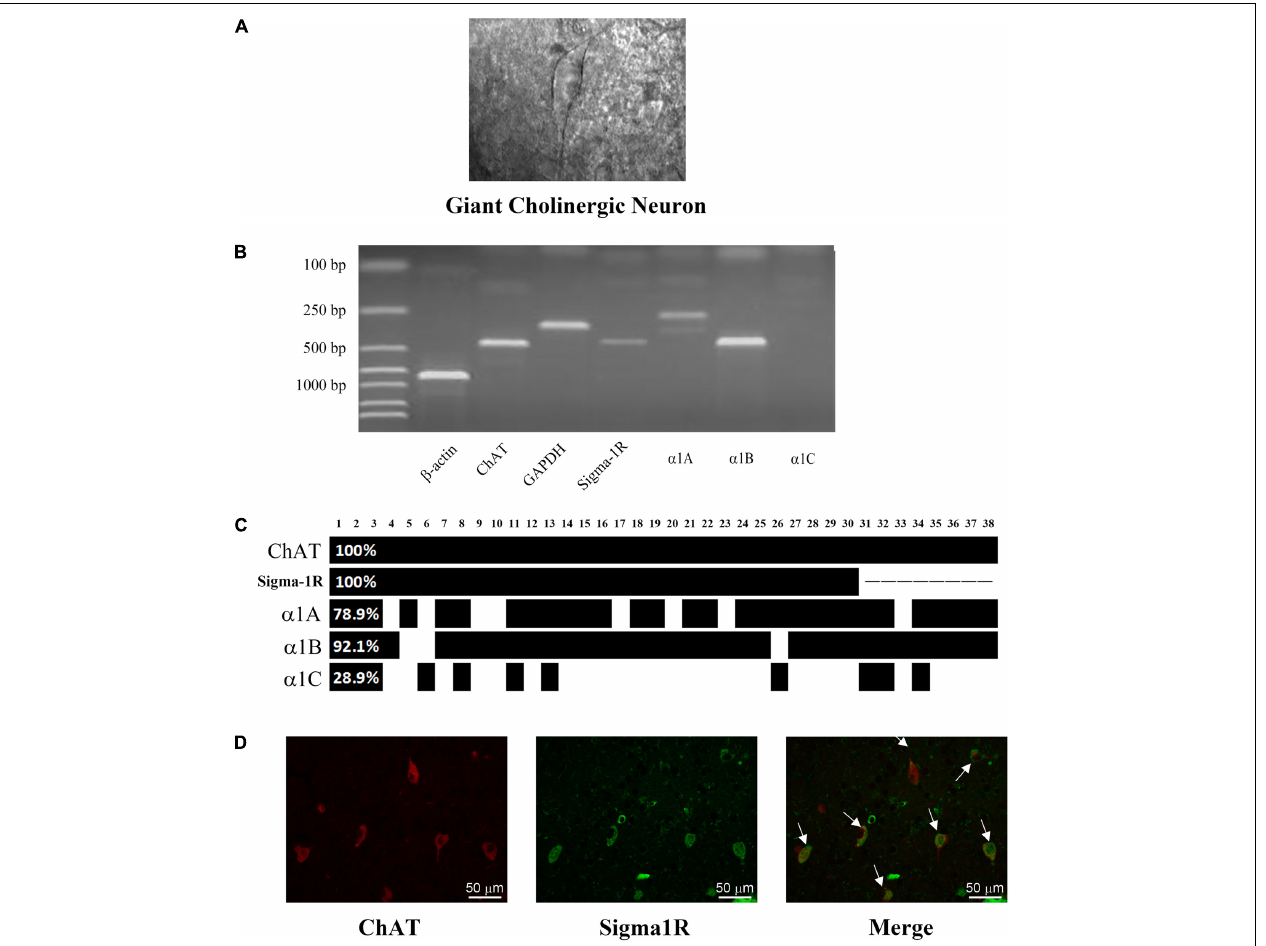
FIGURE 1 | Identification of the expression of N-type Ca 2 + channel and sigma-1 receptor in ChIs. (A) An IR-DIC image of a striatal slice illustrating the characteristic appearance of giant cholinergic interneurons (ChIs). (B) Representative photograph of single-cell reverse transcription polymerase chain reaction (scRT-PCR). Experiment products were stained in a 2% agarose gel. Molecular mass markers were shown in the first lane. β -actin and GAPDH were introduced as positive control. The presence of ChAT indicated the aspirated cell was a ChI. (C) Bar plot indicated the co-expression of ChAT, sigma-1 receptor and α 1A-C in ChIs by scRT-PCR. ChAT and sigma-1 receptor were in every detected neuron. The α 1B subunit of N-type Ca 2 + channel was found in 92.1% detected cells. (D) Immunofluorescence of successive paraffin-embedded rat striatum slice observed under 40 × objective lens. Left: using the anti-sigma-1 receptor antibody at a dilution of 1:20 and FITC-conjugated affinipure goat anti-rabbit IgG. Middle: Using the anti-ChAT antibody at a dilution of 1:200 and TRITC-conjugated affinipure rabbit anti-goat IgG. Right: the merged picture of the sigma-1 receptor and ChAT.